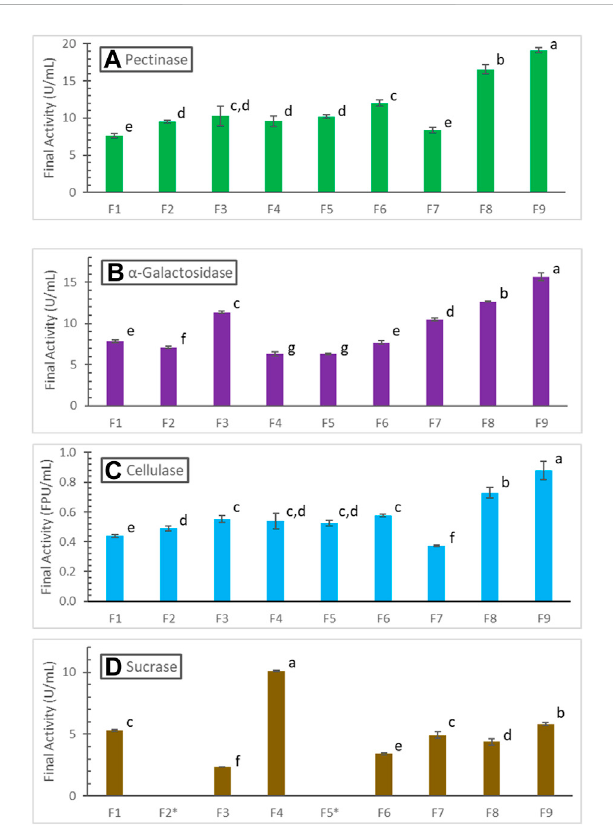
FIGURE 4 Comparison of (A) pectinase, (B) α -galactosidase, (C) cellulase, and (D) sucrase production in different fermentations (see conditions in Table 1; sucrase not measured in F2 and F5). Activities are grouped and labeled according to the Tukey ’ s pairwise comparisons, with insigni fi cantly different activities sharing the same letter